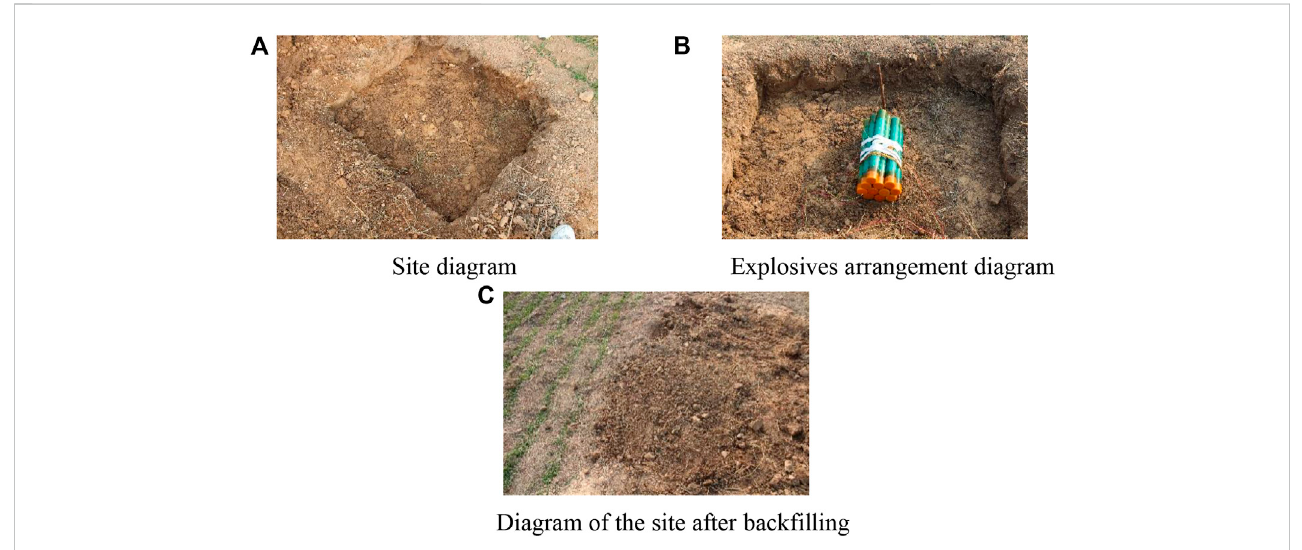
Schematic diagram of the explosive arrangement and back fi ll site. (A) Site diagram. (B) Explosive arrangement. (C) Site after back fi lling.